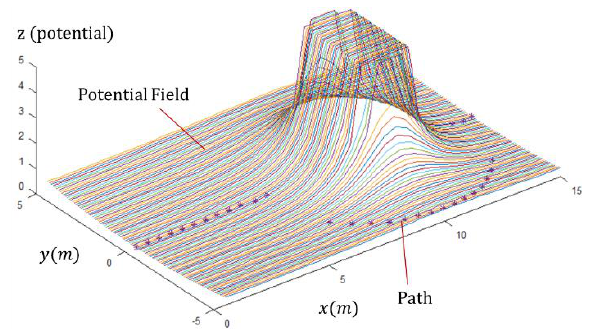
Figure 4. Potential field algorithm [24].